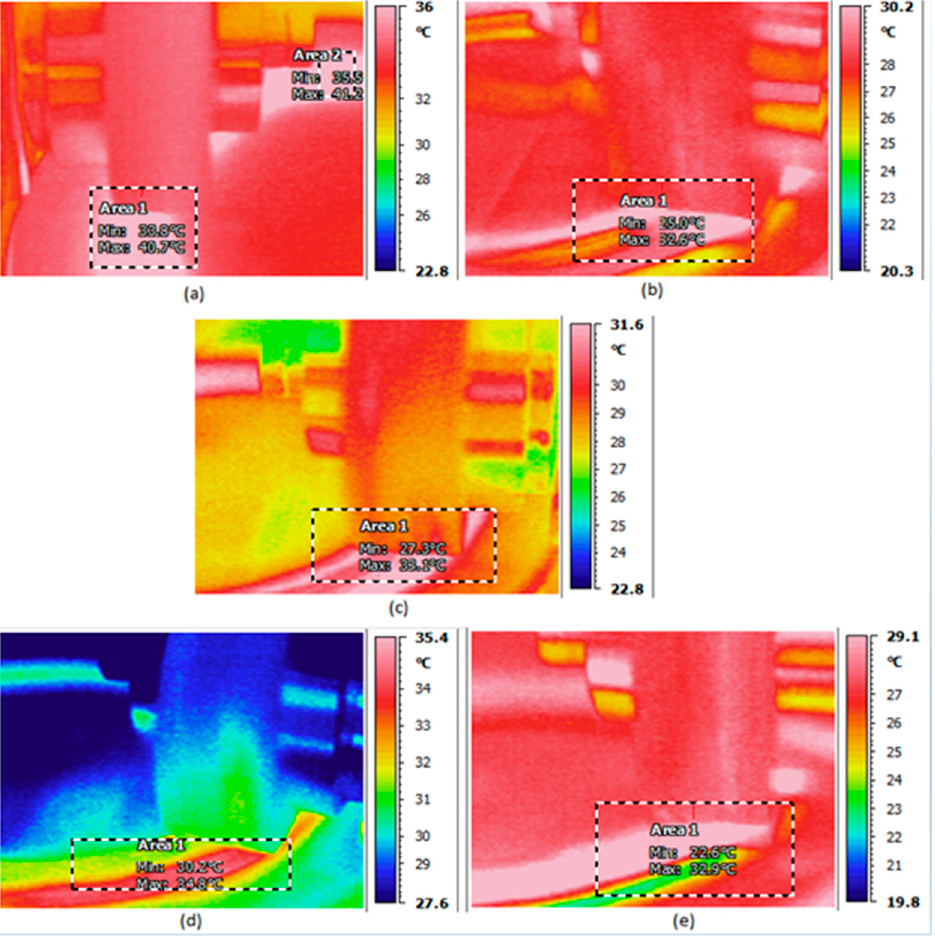
Figure 7. Thermal images for ( a ) epoxy, ( b ) epoxy–kenaf, ( c ) 0.5 wt.% PMWCNT–epoxy–kenaf, ( d ) 0.75 wt.% PMWCNT–epoxy–kenaf, and ( e ) 1 wt.% PMWCNT–epoxy–kenaf composites.